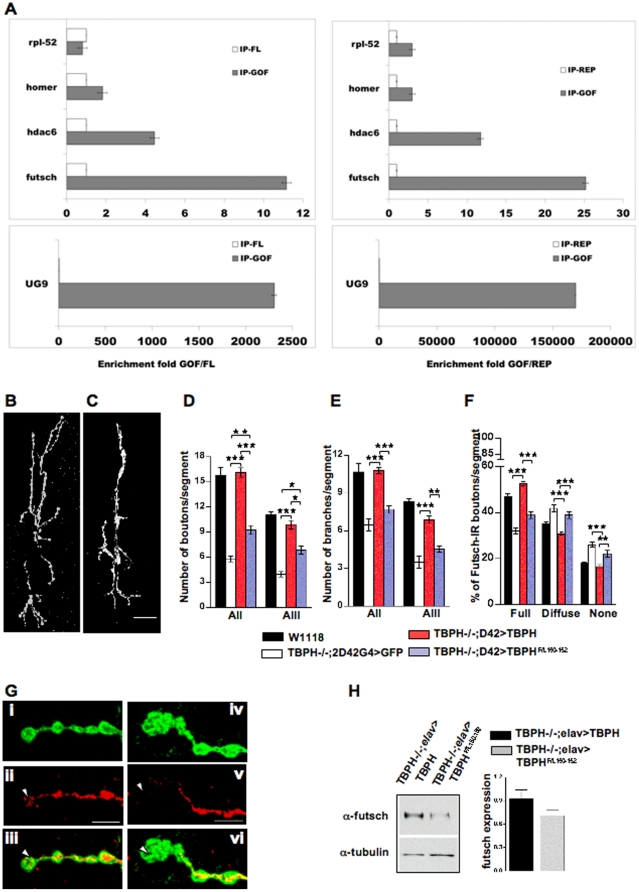
TBPH binding to futsch mRNA is required for NMJ growth and MT organization.(A) qPCR analysis of mRNAs immunoprecipitated by Flag-tagged TBPH. The enrichment-fold is referred to an unrelated protein (REP, Right charts) or to the mutant TBPHF/L150–152 (FL, Left charts). Significant levels of enrichment were observed for futsch mRNA, together with hdac-6 mRNA and the (UG)9 RNA used as positive controls. The mRNAs of the ribosomal protein rpl-52 and homer were not enriched significantively. (B) Wild type TBPH protein expression in TBPHD23/-;D42>TBPH flies succeed to rescue the synaptic growth compared to (C) TBPH RRM1 mutant isoform in TBPHD23/-;D42>TBPHF/L150–152 larval NMJ, Scale bar 20 µm. (D) Quantifications of big synaptic boutons and (E) terminal branches in muscle 6–7 (abdominal segments II and III) in TBPHF/L150–152 and TBPH wild type rescues. (F) Quantifications showing the reduced futsch staining in the distal boutons of TBPHF/L150–152 rescue NMJs compared to wild type TBPH protein. n = 12 larvae. ***p<0.001, **p<0.01. (G) Confocal images showing reduced futsch positive staining in the distal boutons of TBPHF/L150–152 rescues (Giv-Gvi see arrowhead) compared to wild type TBPH rescues (Gi-Giii). Scale bar 5 µm. (H) Western blot analysis and the respective histogram showing the reduced levels of futsch protein expression in TBPHD23/-;elav>TBPHF/L150–152 compared with TBPHD23/-;elav>TBPH (upper panel) n = 3. Tubulin was used as a loading control (bottom panel).